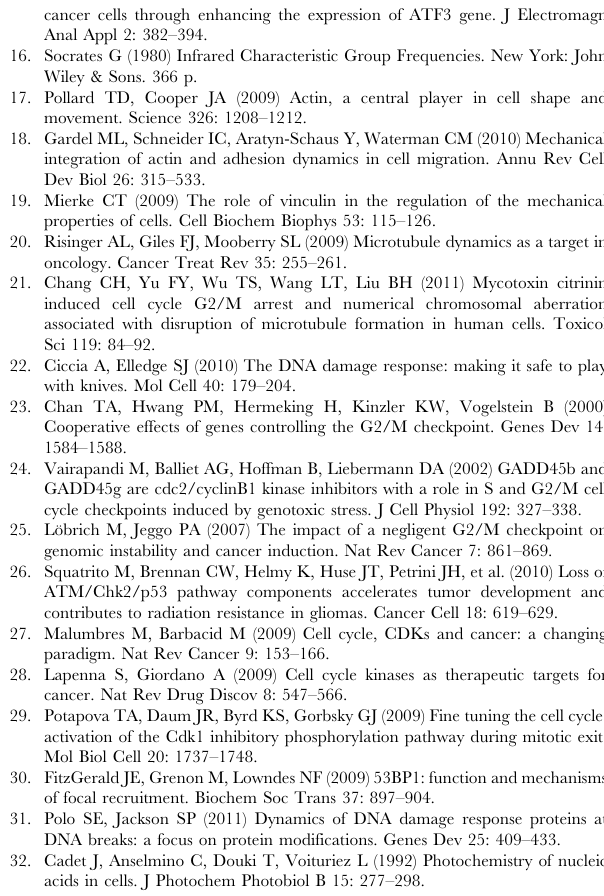
Figure S2 The cell viability and morphology of MRC-5 cells were not affected by 48-hour exposure to MIR. (A)